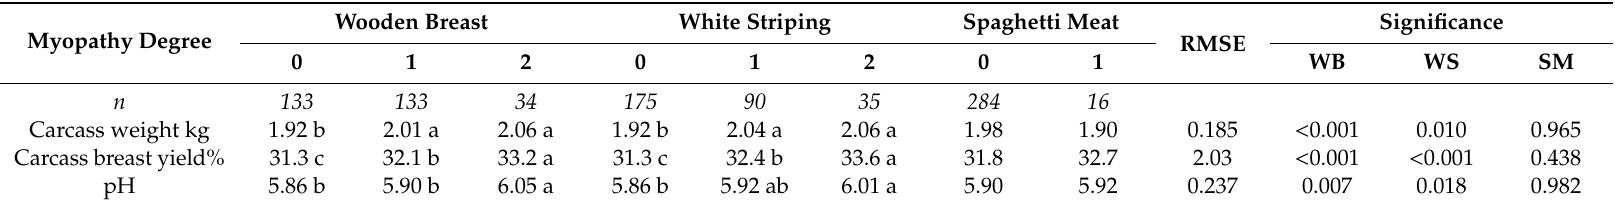
Table 1. Carcass quality and pH of broiler breast with di ff erent degree of myopathies.